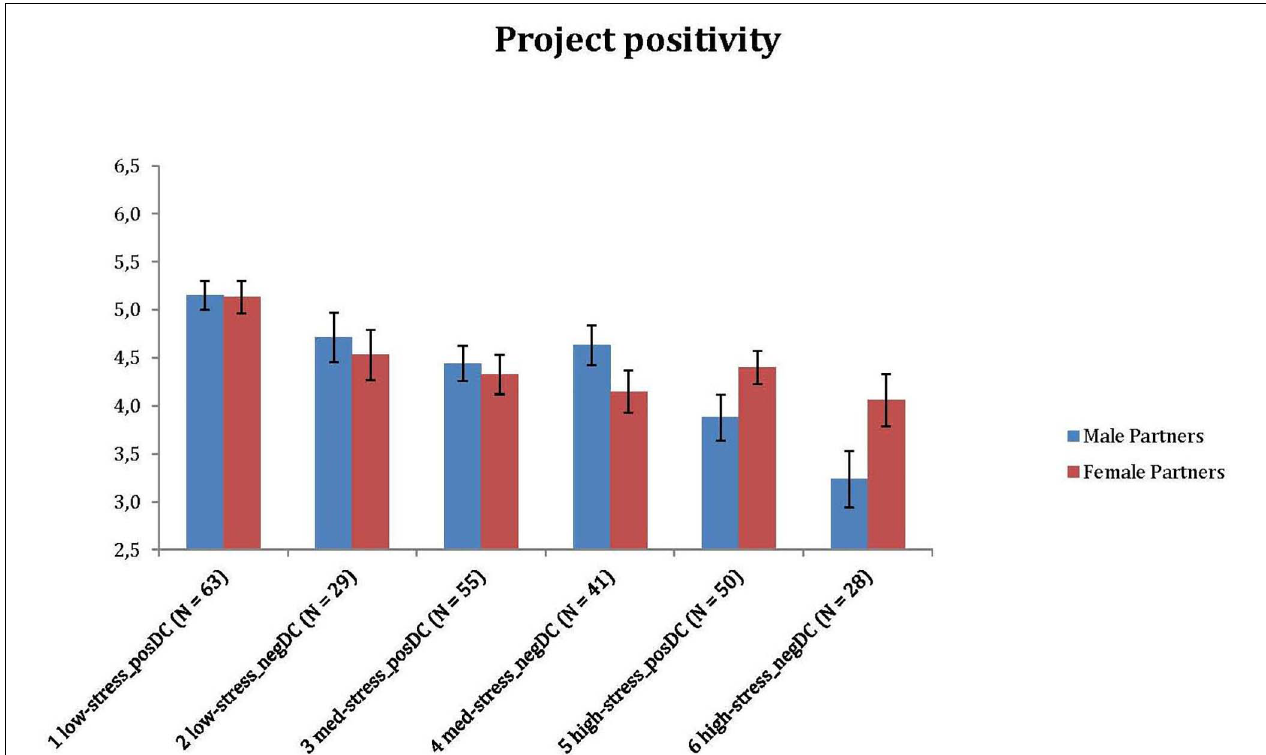
FIGURE 4 | Differences of clusters: positive emotions in personal